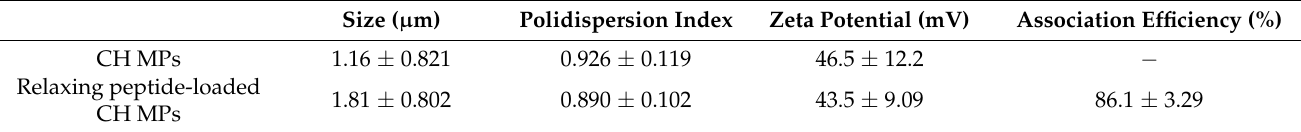
Table 1. Characteristics of unloaded CH MPs and relaxing peptide-loaded CH MPs (CH MPs + Peptide) (mean ± sd (n =